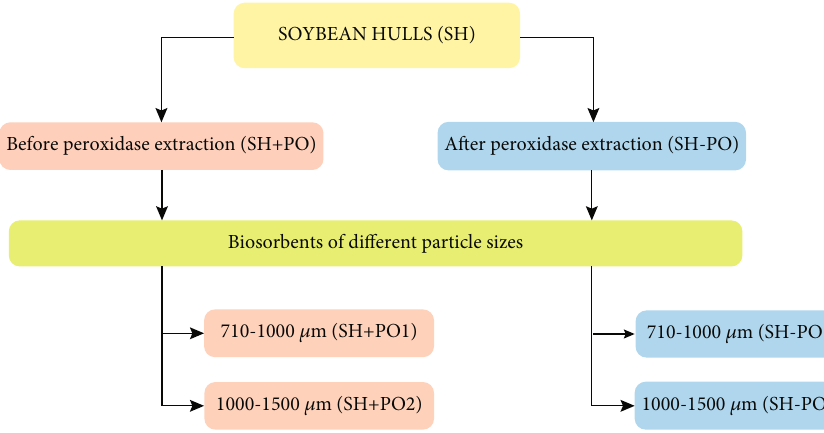
Figure 1: Adsorbents ’ abbreviations.